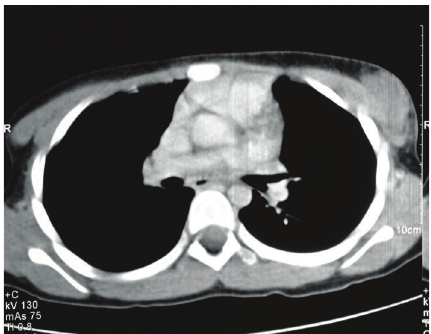
Figure 8: Ultrasound of the chest/axilla showing a cystic mass with septations in the right lateral chest wall near the right axilla, 5cm × 4 cm.